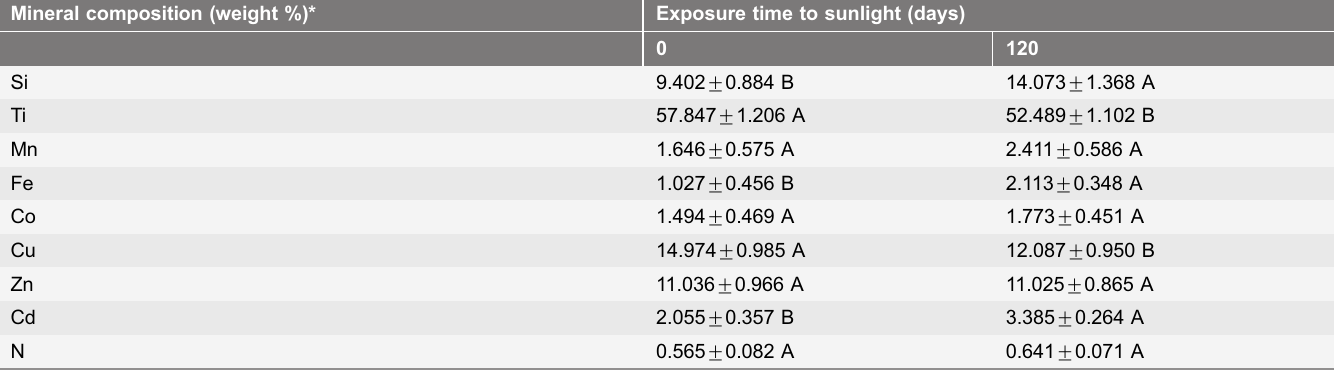
Table 1. Chemical composition of the oxo-biodegradable plastic before and after 120 days of sunlight exposure. Mineral composition (weight %)*